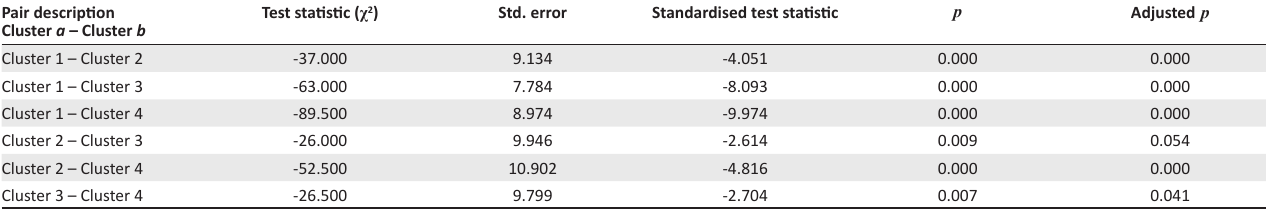
TABLE 5: Pair-wise comparison of clusters based on Kruskal–Wallis test and ANOVA test results. Pair description Cluster a – Cluster b